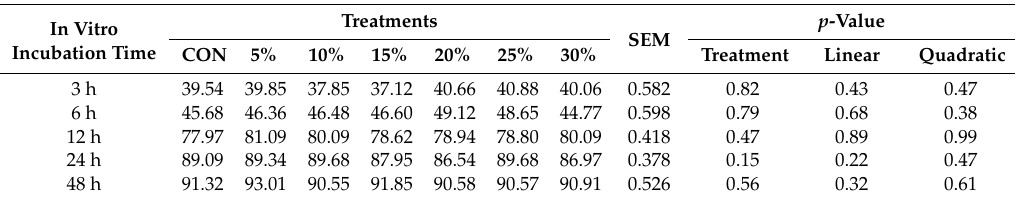
Table 3. E ff ects of di ff erent cassava residue substitution ratio for crushed maize on in vitro IVDMD in dairy cows at mid-lactation